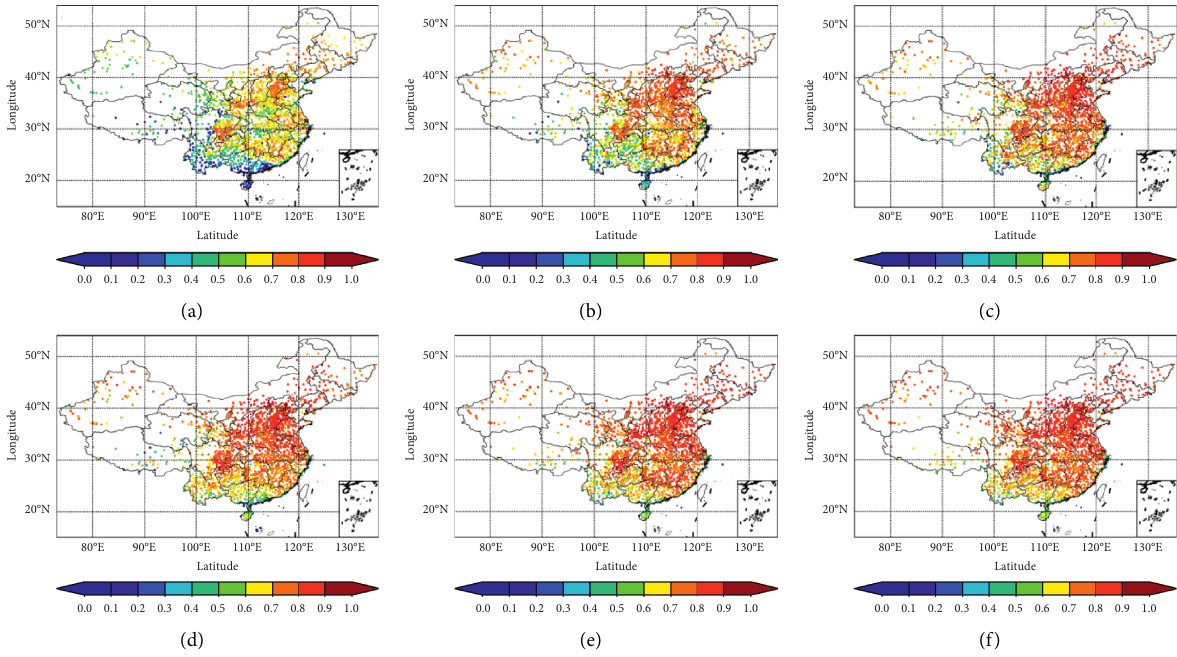
Figure 8: Spatial distribution of R 2 for six machine-learning models. (a) MLR-R 2 . (b) RF-R 2 . (c) KNN-R 2 . (d) DNN-R 2 . (e) GBTD-R 2 . (f) XGB-R 2